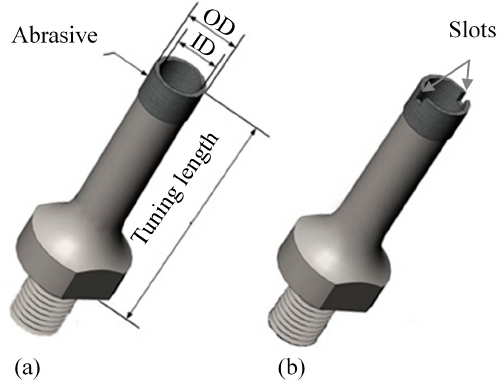
Figure 3. Illustration of cutting tools. ( a ) Tool in continuous RUM; ( b ) Tool in intermittent RUM.